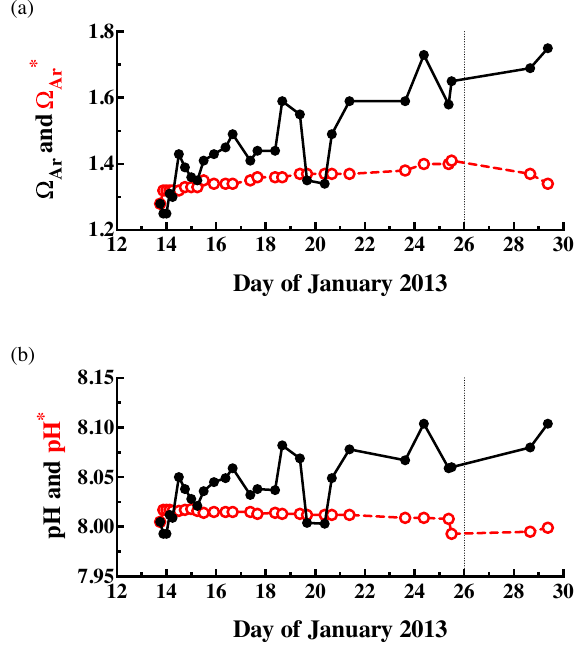
Figure 10. Evolution of (a) (cid:127) aragonite in the water column, calcu- lated based on TA (sw) and TCO 2(sw) (black dots) and calculated based on TA ∗ and TCO ∗ (dashed red line), and (b) pH in the water column calculated based on TA (sw) and TCO 2(sw) (black dots) and calculated based on TA ∗ and TCO ∗ (dashed red